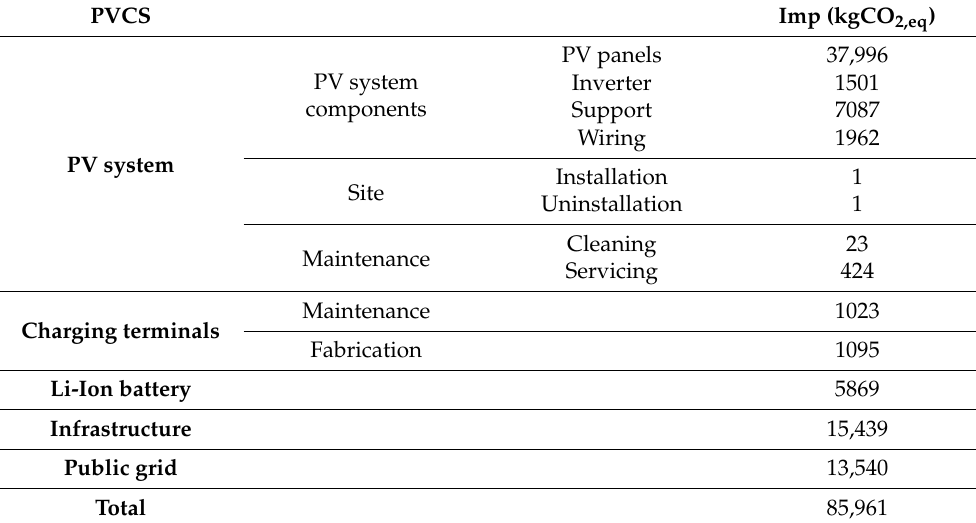
Table 1. Summary table of the carbon impact of each component of the initially considered